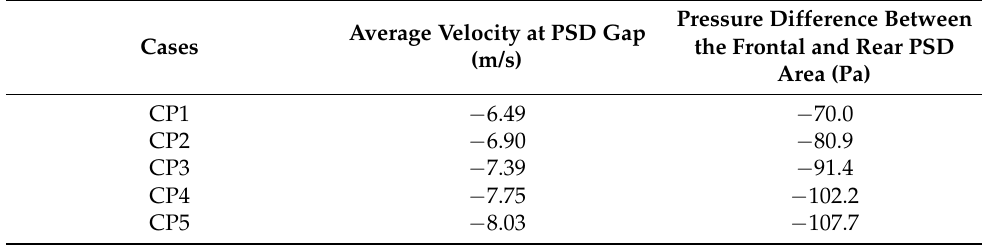
Table 4. Porous media modeling cases results summary.